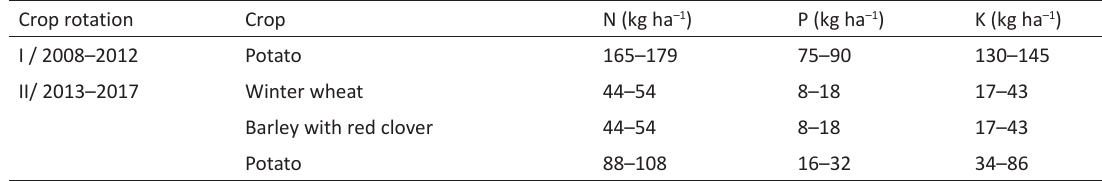
Table 1. N, P and K applied to the organic system in manure